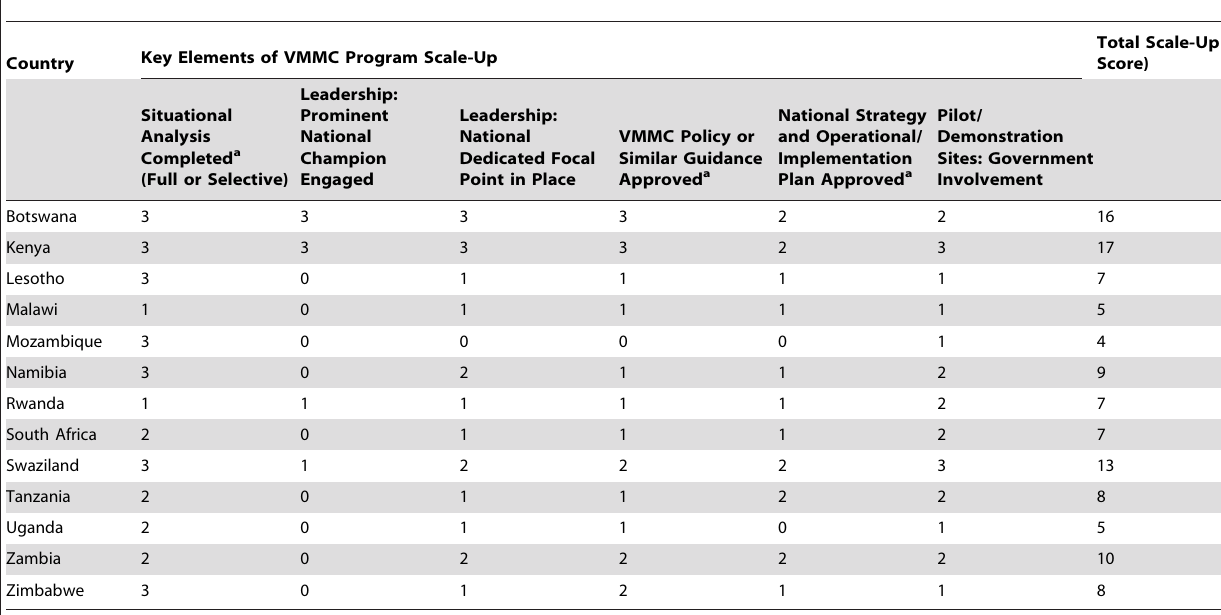
Table 4. Country progress with scaling- up VMMC programs in focal countries (December 2010).